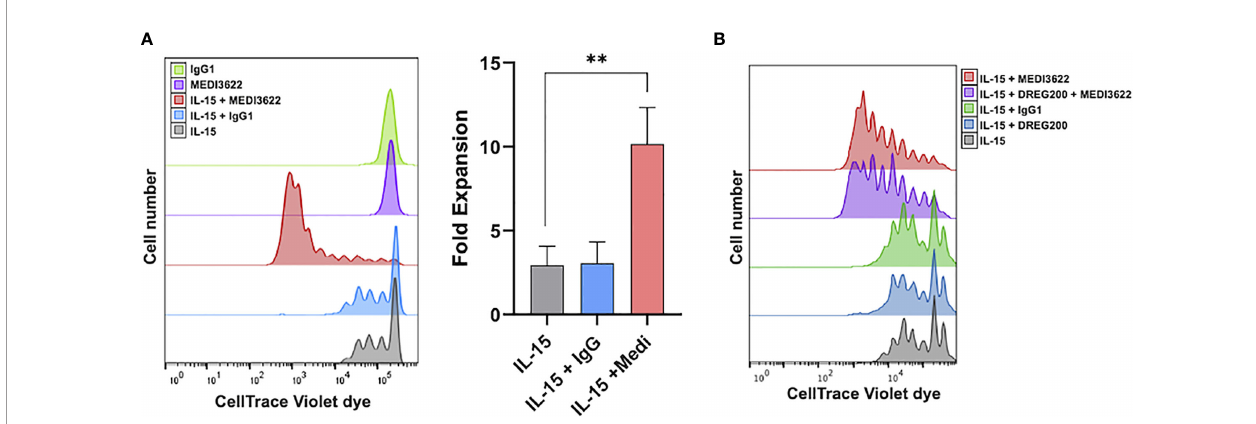
FIGURE 1 | ADAM17 blockade enhances human NK cell proliferation by IL-15 in vitro . (A) Enriched NK cells were labeled with CellTrace Violet dye and placed in culture for 7 days with rhIL-15 (10ng/ml) and/or MEDI3622 (5 m g/ml) and/or control human IgG1 (5 m g/ml), as indicated. Cells were then harvested and examined for CellTrace dye dilution by fl ow cytometry. Data are representative of 3 independent experiments using leukocytes from separate donors. An expansion index was calculated as described in the Methods and is the fold expansion of the overall culture for each condition based on dye dilution. Data are means ± SD of three independent experiments using separate donors. Statistical signi fi cance is indicated as **p < 0.01. Statistics were calculated using one-way ANOVA. (B) Human PBMCs were labeled with CellTrace Violet dye and placed in culture for 7 days with rhIL-15 (10ng/ml), MEDI3622 (5 m g/ml), control human IgG1 (5 m g/ml), and/or DREG200 (5 m g/ml). Cells were then harvested and examined for CellTrace dye dilution by fl ow cytometry. Data are representative of 3 independent experiments using leukocytes from separate